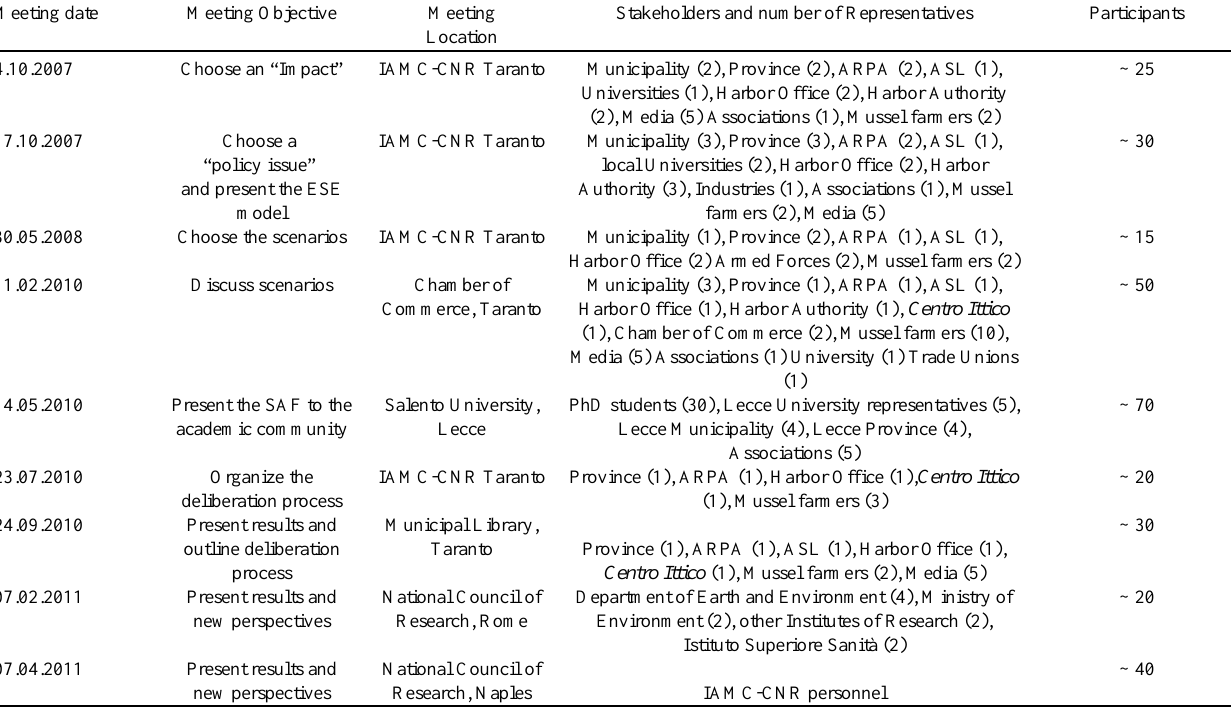
Table 5 . Synthesis of the stakeholder